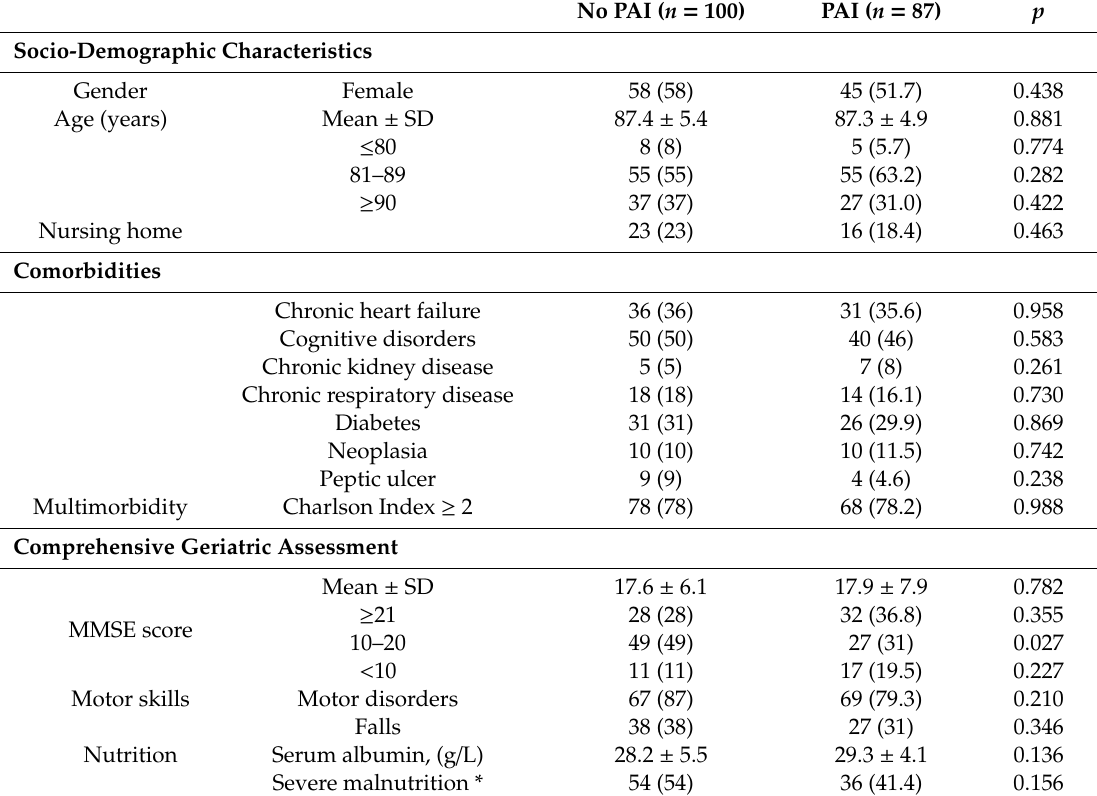
Figure 1. Flow chart. PAI: platelet aggregation inhibitors. The black text boxes indicate inconsistency with current guidelines [20]. Table 1. Characteristics of patients with an indication for platelet aggregation inhibitors (PAI) (n (%) or mean ± standard deviation).